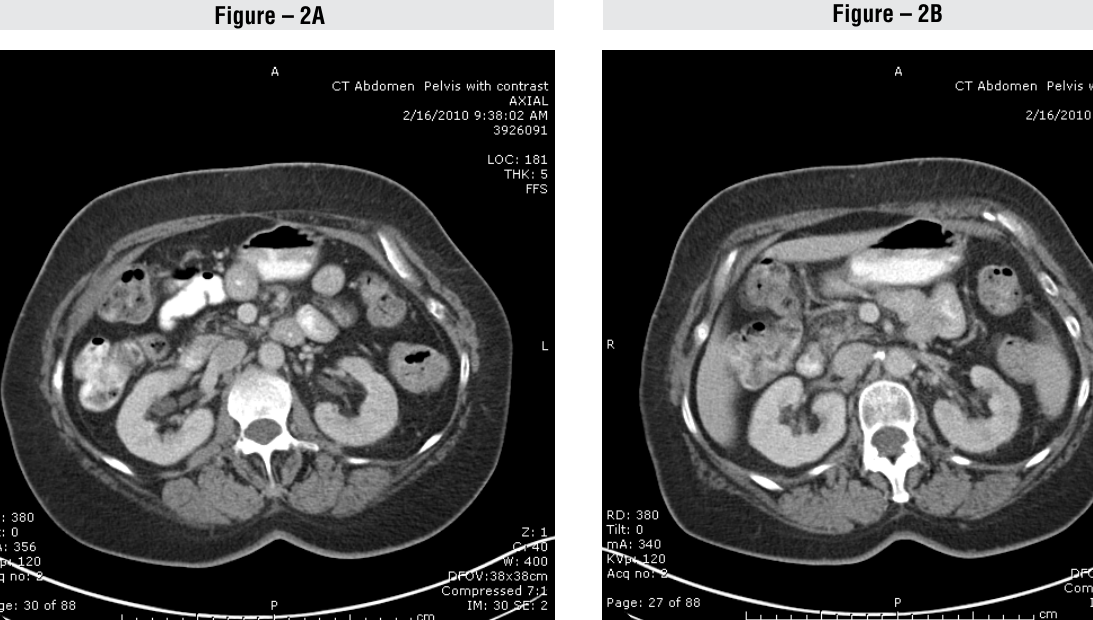
Figure 2 - Follow-up CT scan at 20 weeks showing resolution of bilateral renal vein